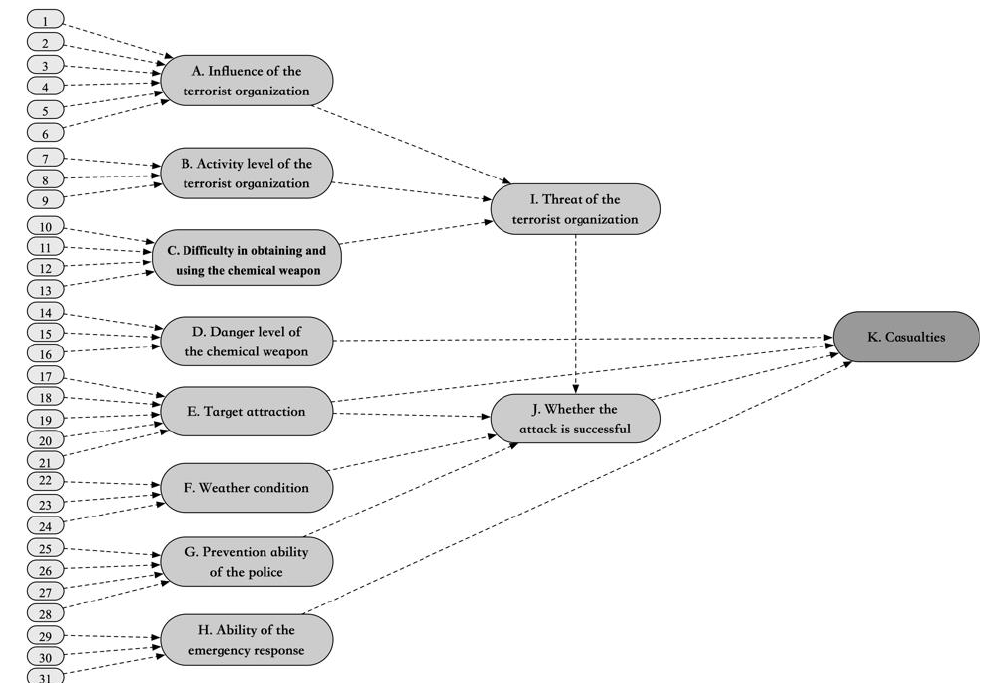
Figure 2. Bayesian network for representing chemical terrorist attack. The description of each node is shown in Table 1.